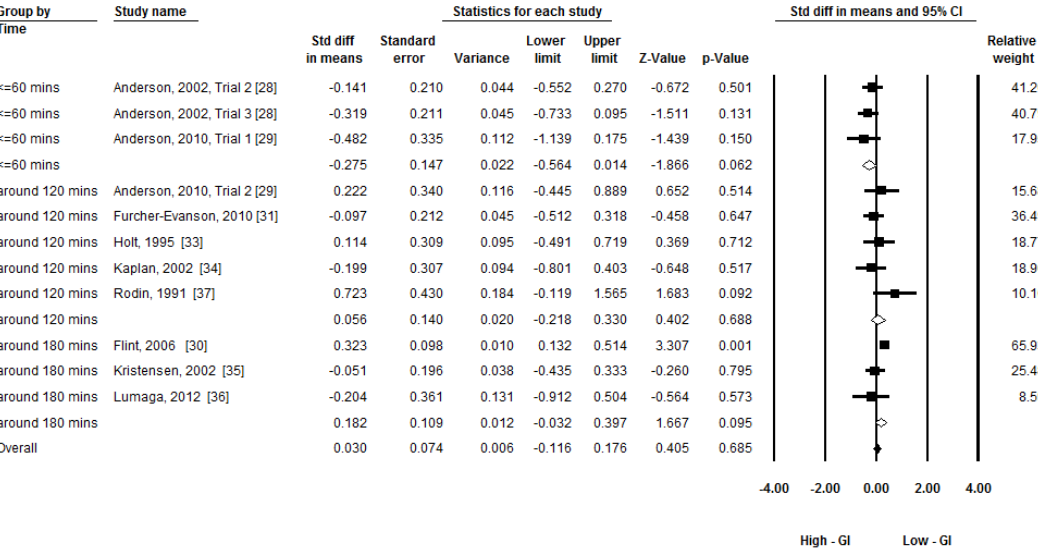
Figure 4. Subgroup meta ‐ analysis: The effect of low ‐ GI and high ‐ GI breakfast on subsequent energy intake at 60, 120, and 180 min. (GI: Glycemic Index).